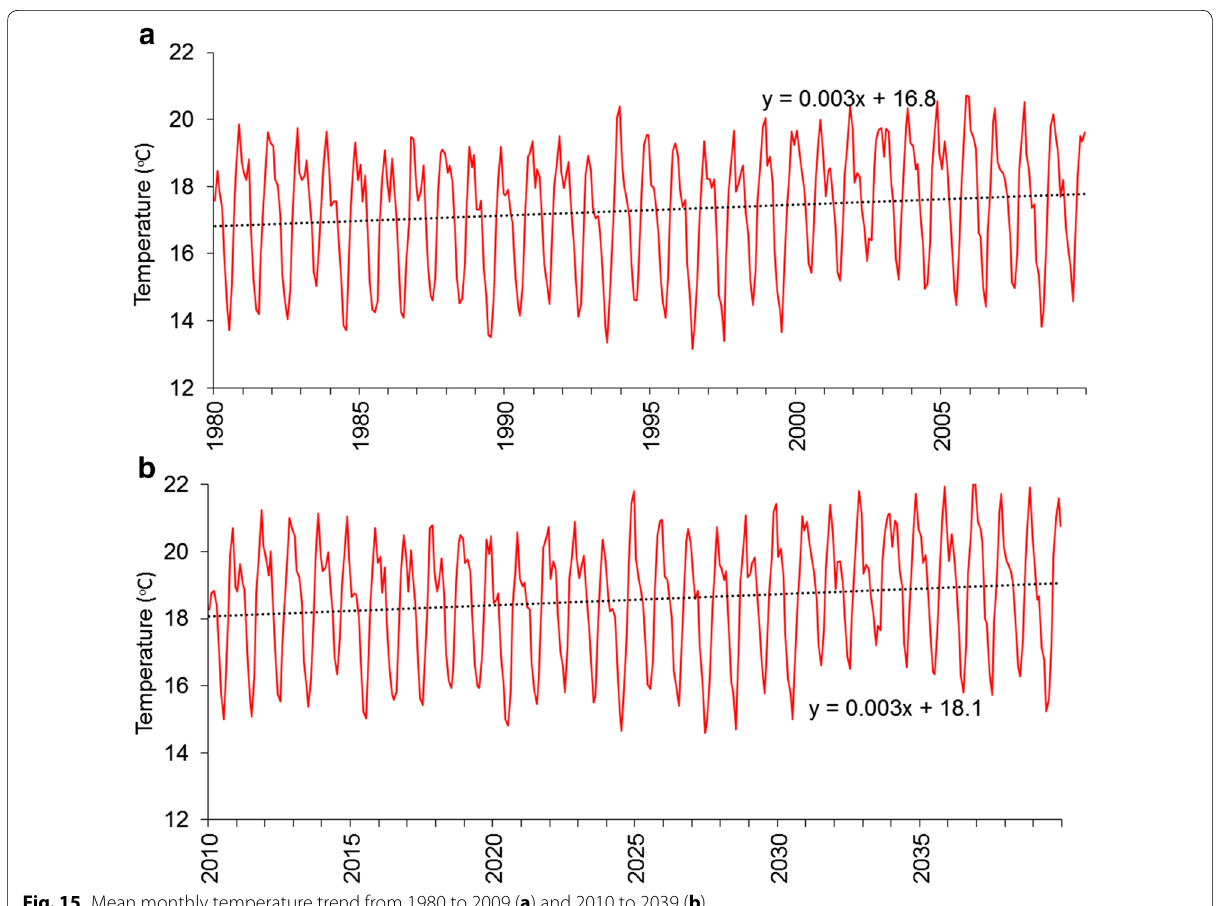
Fig. 15 Mean monthly temperature trend from 1980 to 2009 ( a ) and 2010 to 2039 ( b )